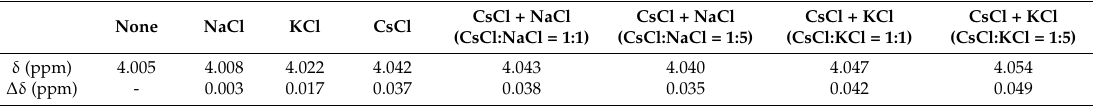
Table 4. Chemical shifts ( δ ) and their changes ( ∆ δ ) of methylene protons of DB24C8 in P9 in the competition test.